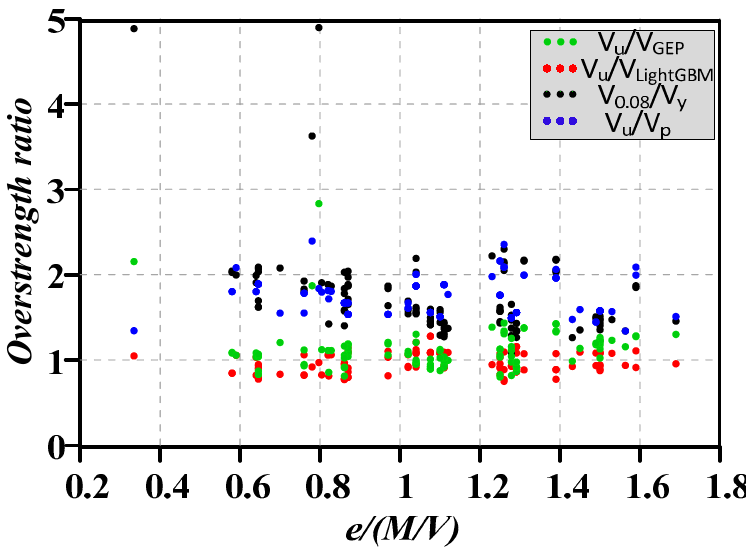
Figure 12. Performance of overstrength ratio vs. link length ratio for various models.